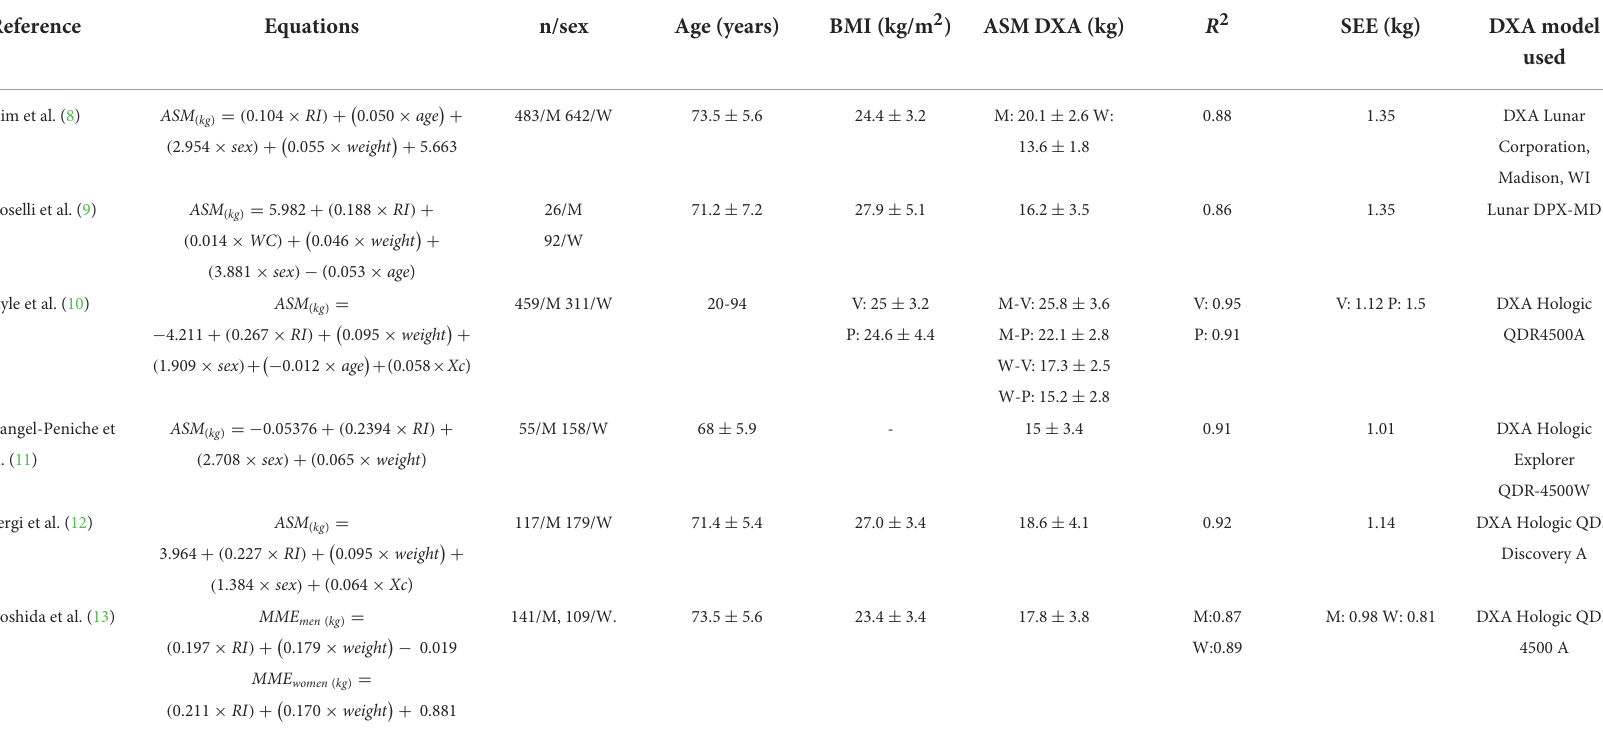
TABLE 2 Selected equations and their characteristics.